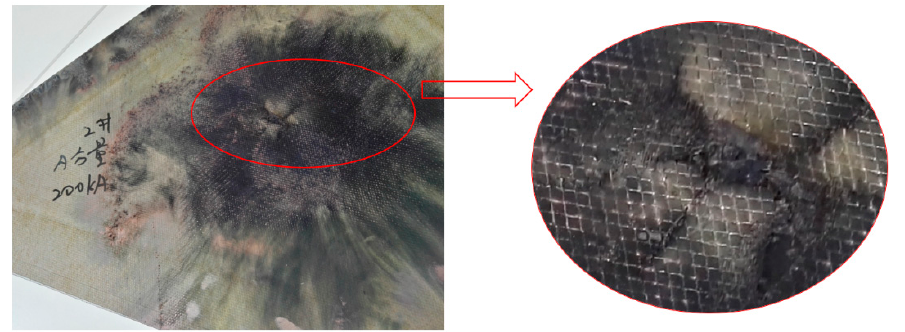
Figure 13. Damage patterns in the copper mesh covered CFRP laminates in the 200 kA lightning current test.